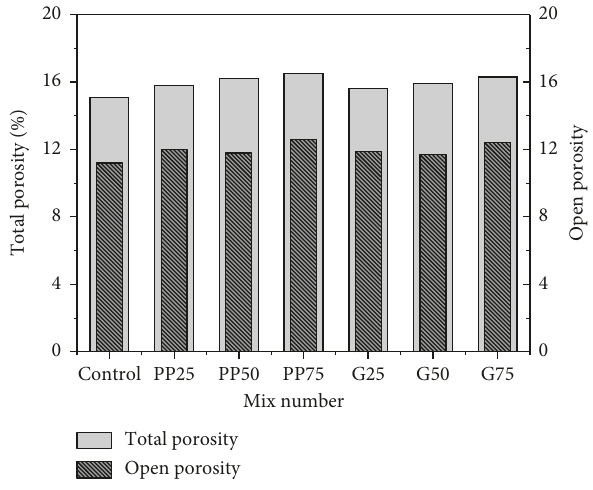
Figure 14: Total and open porosity of